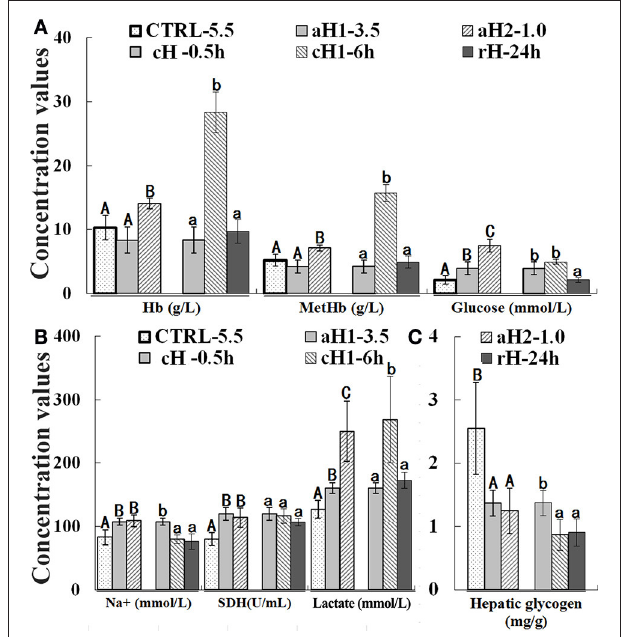
FIGURE 1 | Effect of hypoxia upon hemoglobin (Hb), methemoglobin (MetHb), and glucose (A) , Na + , succinatedehydrogenase (SDH) and lactate (B) , and hepatic glycogen (C) concentrations in Megalobrama amblycephala . CTRL-5.5, the control; aH1-3.5 and aH2-1.0, acute hypoxia at 1.0 and 3.5 mg/L of DO last for 0.5h, respectively; cH-0.5h and cH1-6h, comparable-acute hypoxia (DO: 3.5 mg/L) last for 0.5 and 6h, respectively; rH-24h, hypoxia (DO: 3.5 mg/L) last for 6 h and then recover to DO: 5.5 mg/L for 24 h. Three different DO level groups are individually analyzed and indicated with capital letters, while three hypoxia time condition groups are also separately analyzed and showed with lowercase letters. Different letters above bars represent significant difference ( p < 0.05), and the same letters above bars indicate no significant difference. Values are mean ± S.D.; N = 5 for every